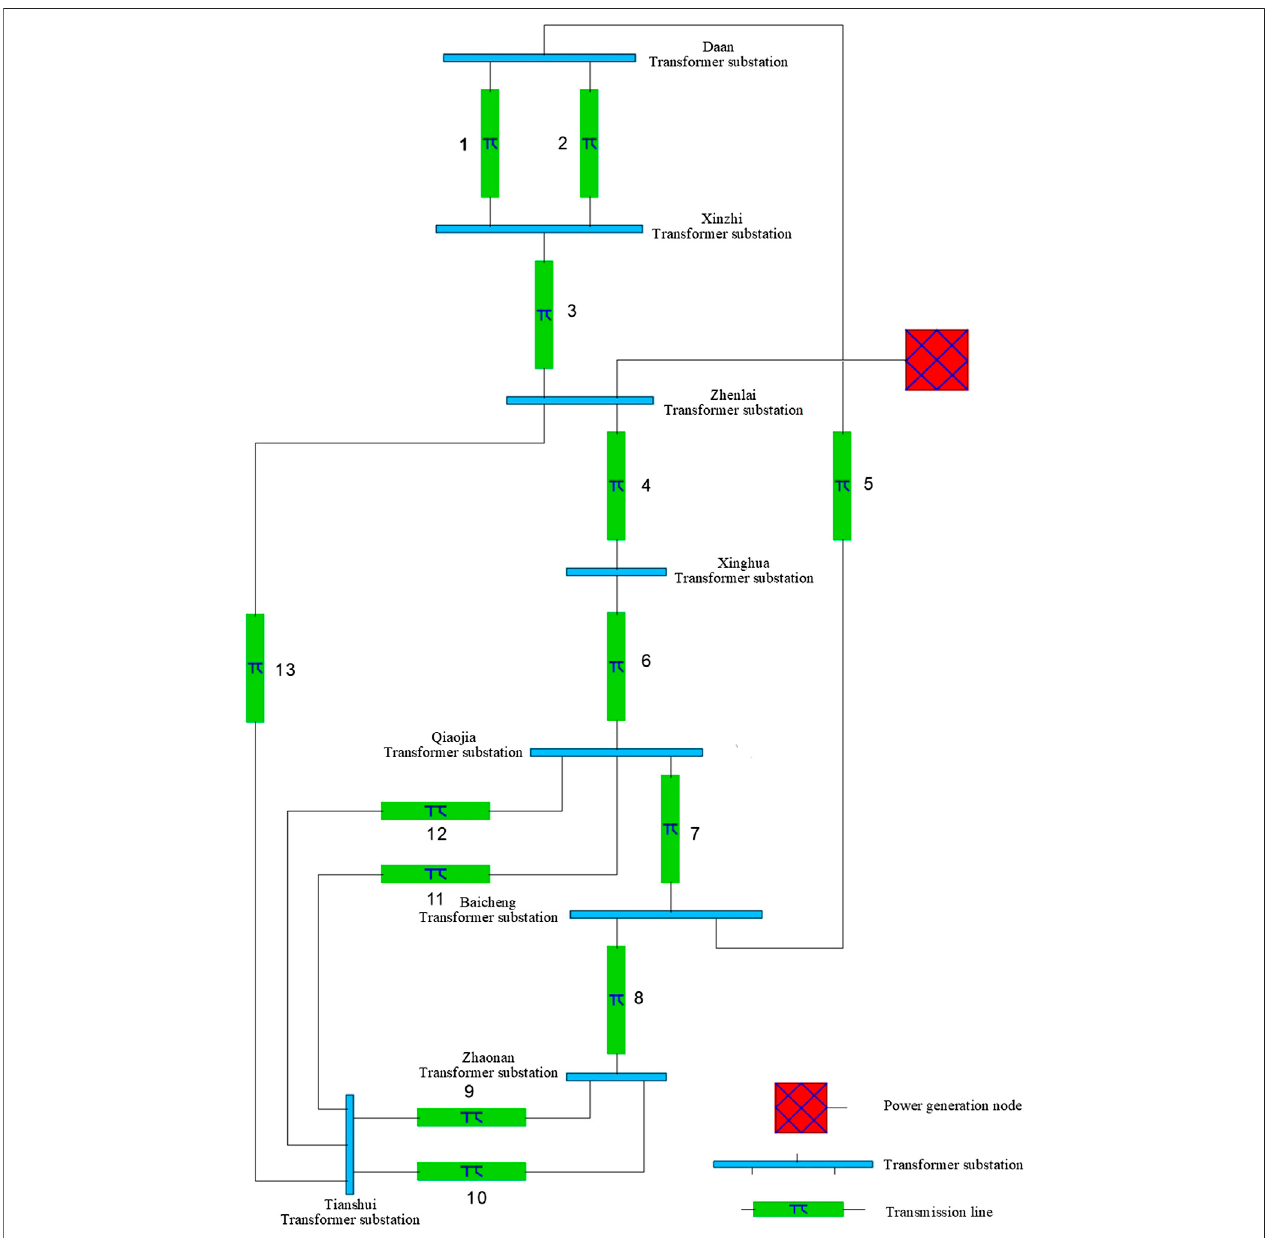
FIGURE 1 | Network topology